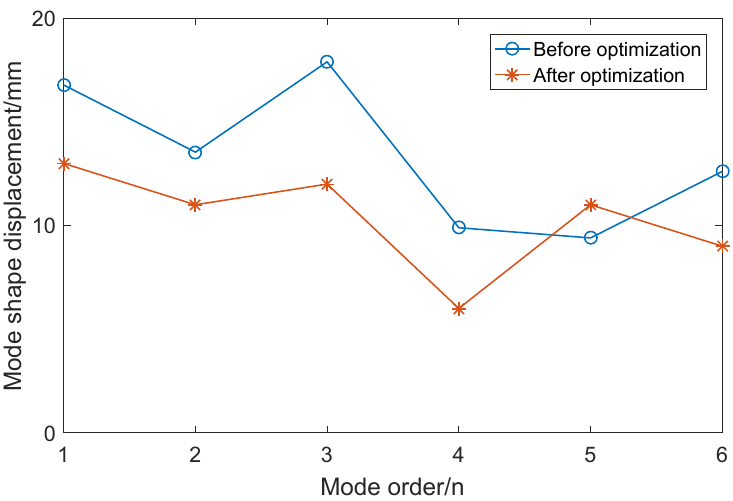
Figure 12. Comparison of mode shape displacement results before and after optimization.